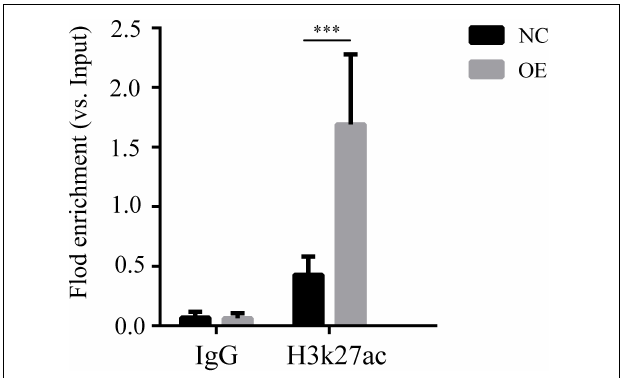
FIGURE 3 | Acetylation of histone H3K27 adjacent to the Kank1 promoter was detected by ChIP. All samples were tested in triplicate, and three multiple holes were made in each experiment. Enrichment of the target gene Kank1 was detected by RT-qPCR ( ∗∗∗ P < 0.001). Student’s t -test was used for comparisons between two groups. Two-tailed P -values less than 0.05 were considered statistically